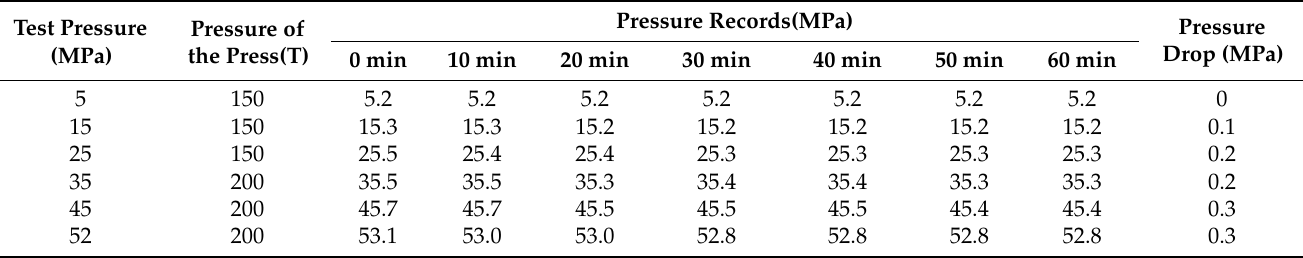
Figure 24. Pressure drop and leakage rate for the experimental device.